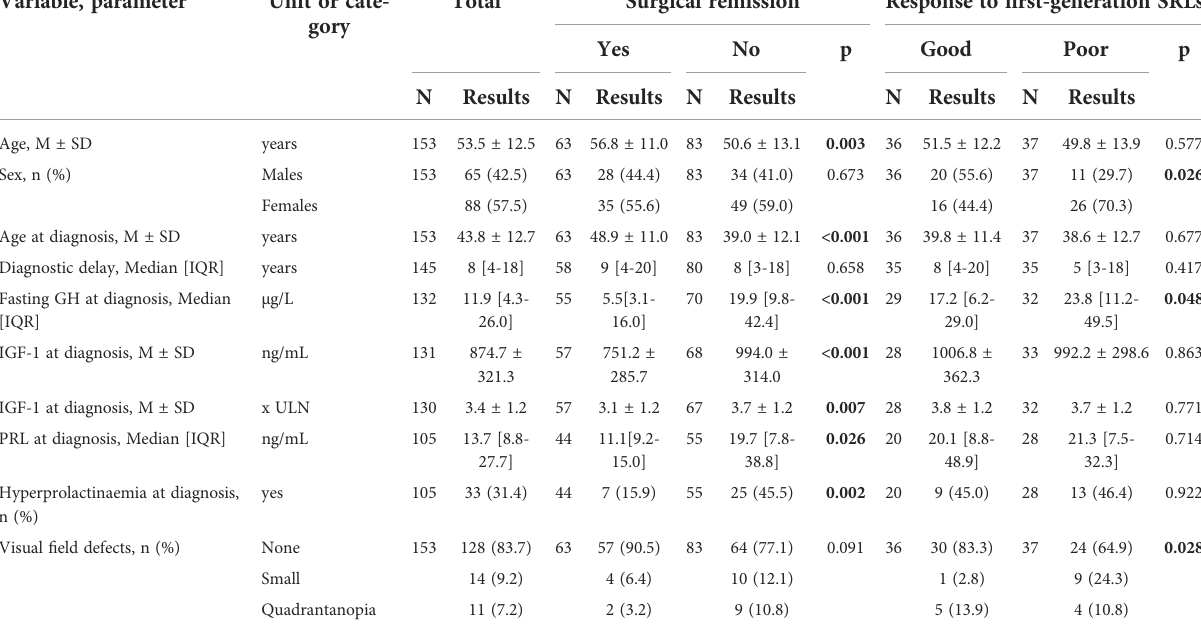
TABLE 1 Clinical presentation of the study cohort. Variable,